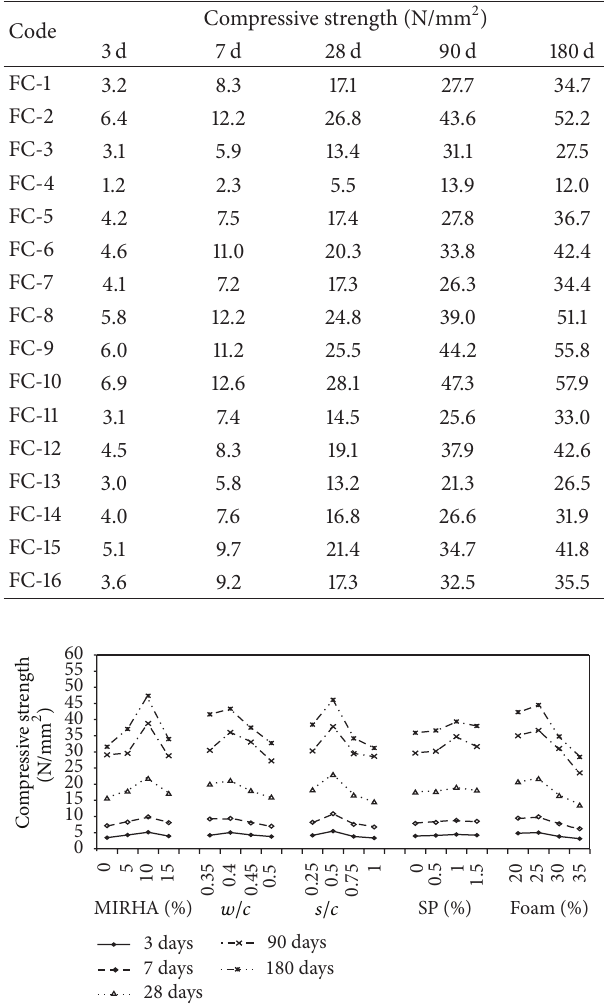
Table 5: Test results of compressive strength for MIRHA FC.